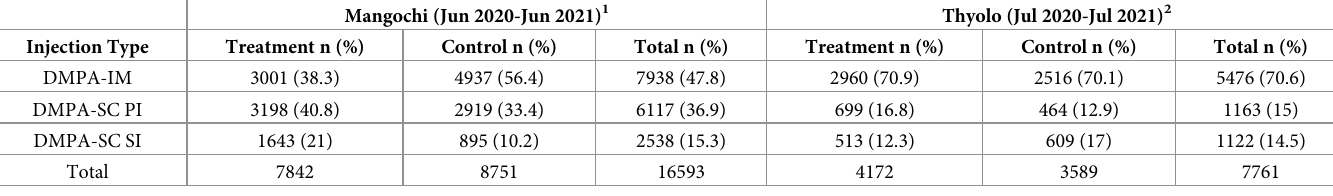
Table 1. New family planning clients who used injectables, by district and injection type (Malawi DHIS2